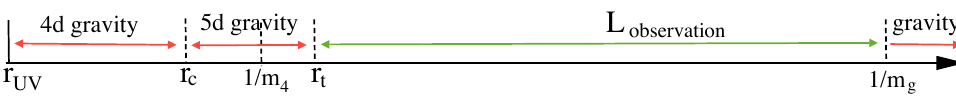
Figure 13 . The horizontal direction represents the hierarchy of distance scales in the \massive gravity 1" scenario. The regime corresponding to the observed massless 4d gravity is represented in green. Gravity is modi(cid:12)ed at short distances at the scale r t , below which it becomes (cid:12)ve- dimensional, and at large distances at the scale 1 =m g , above which it becomes